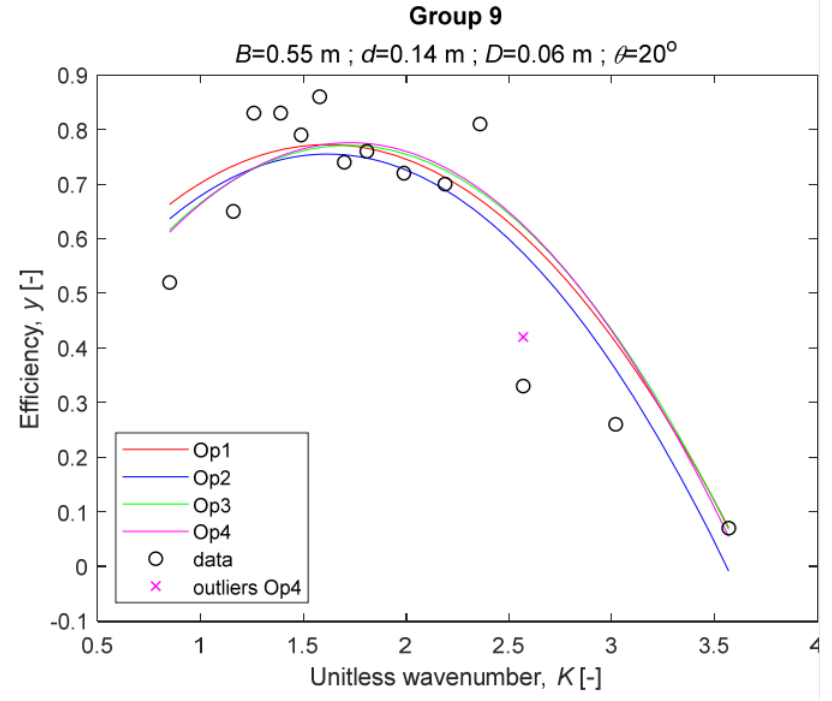
Figure 11. The four models for Group 9. The outliers for a model are denoted above the point with a cross in a respective